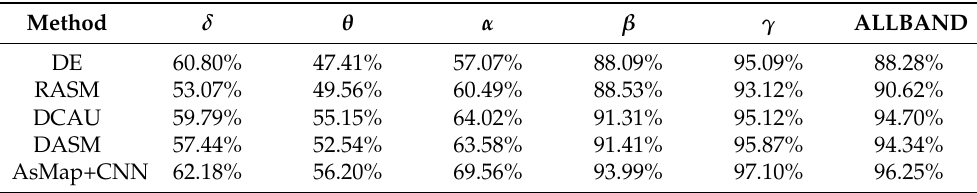
Table 1. Three-class classification accuracy obtained using different feature extraction techniques on frequency